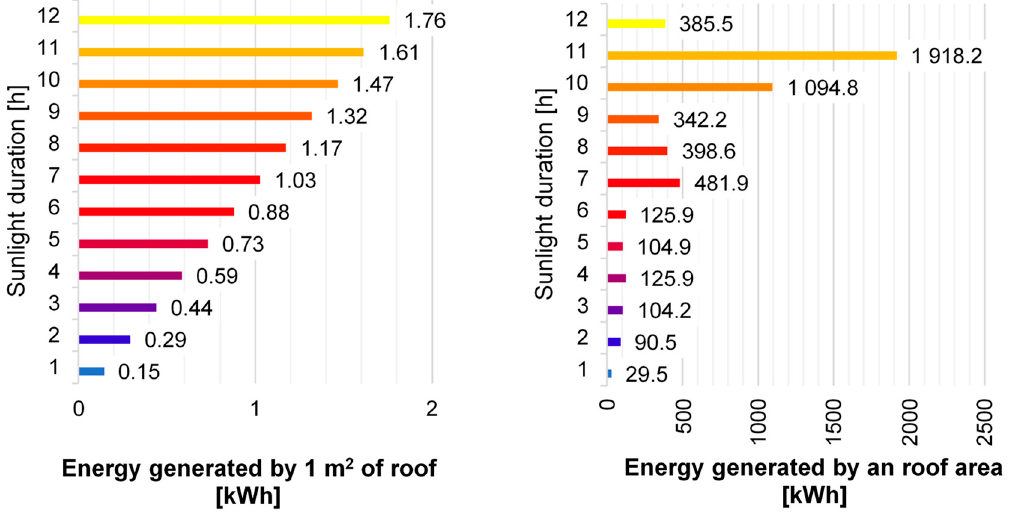
Figure 12. Defining power potential of the analysed building block: on the left: amount of energy generated by 1 m 2 of the roof during insolation; on the right: amount of energy generated by roof surfaces, corresponding to the insolation time.